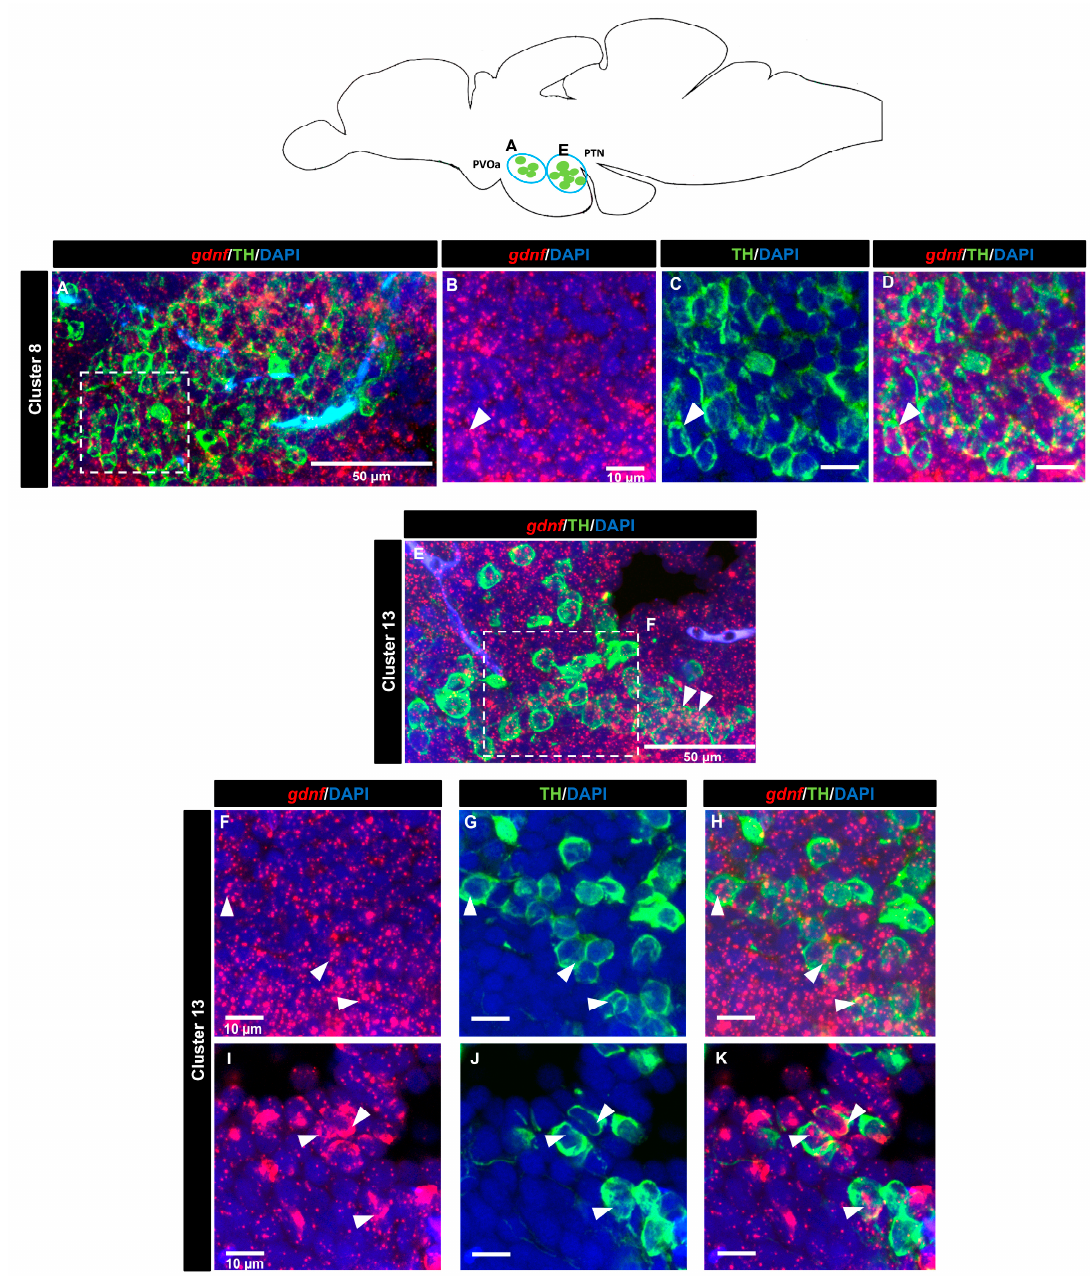
Figure 9. gdnf mRNA is detected in catecholaminergic subpopulations in the ventral diencephalon. Distribution of neuronal clusters expressing gdnf (red) and TH (green) of ( A – D ) cluster 8 in the paraventricular organ, anterior part (PVOa) and ( E – K ) cluster 13 in the periventricular hypothalamus and posterior tuberal nucleus (PTN). Blue circles in the schematic sagittal view of the adult zebrafish brain represent the regions of the respective TH subpopulation neurons. White dashes outline the magnified regions that were constructed from selected z-stacks. The white arrowheads indicate the co-expression of gdnf and